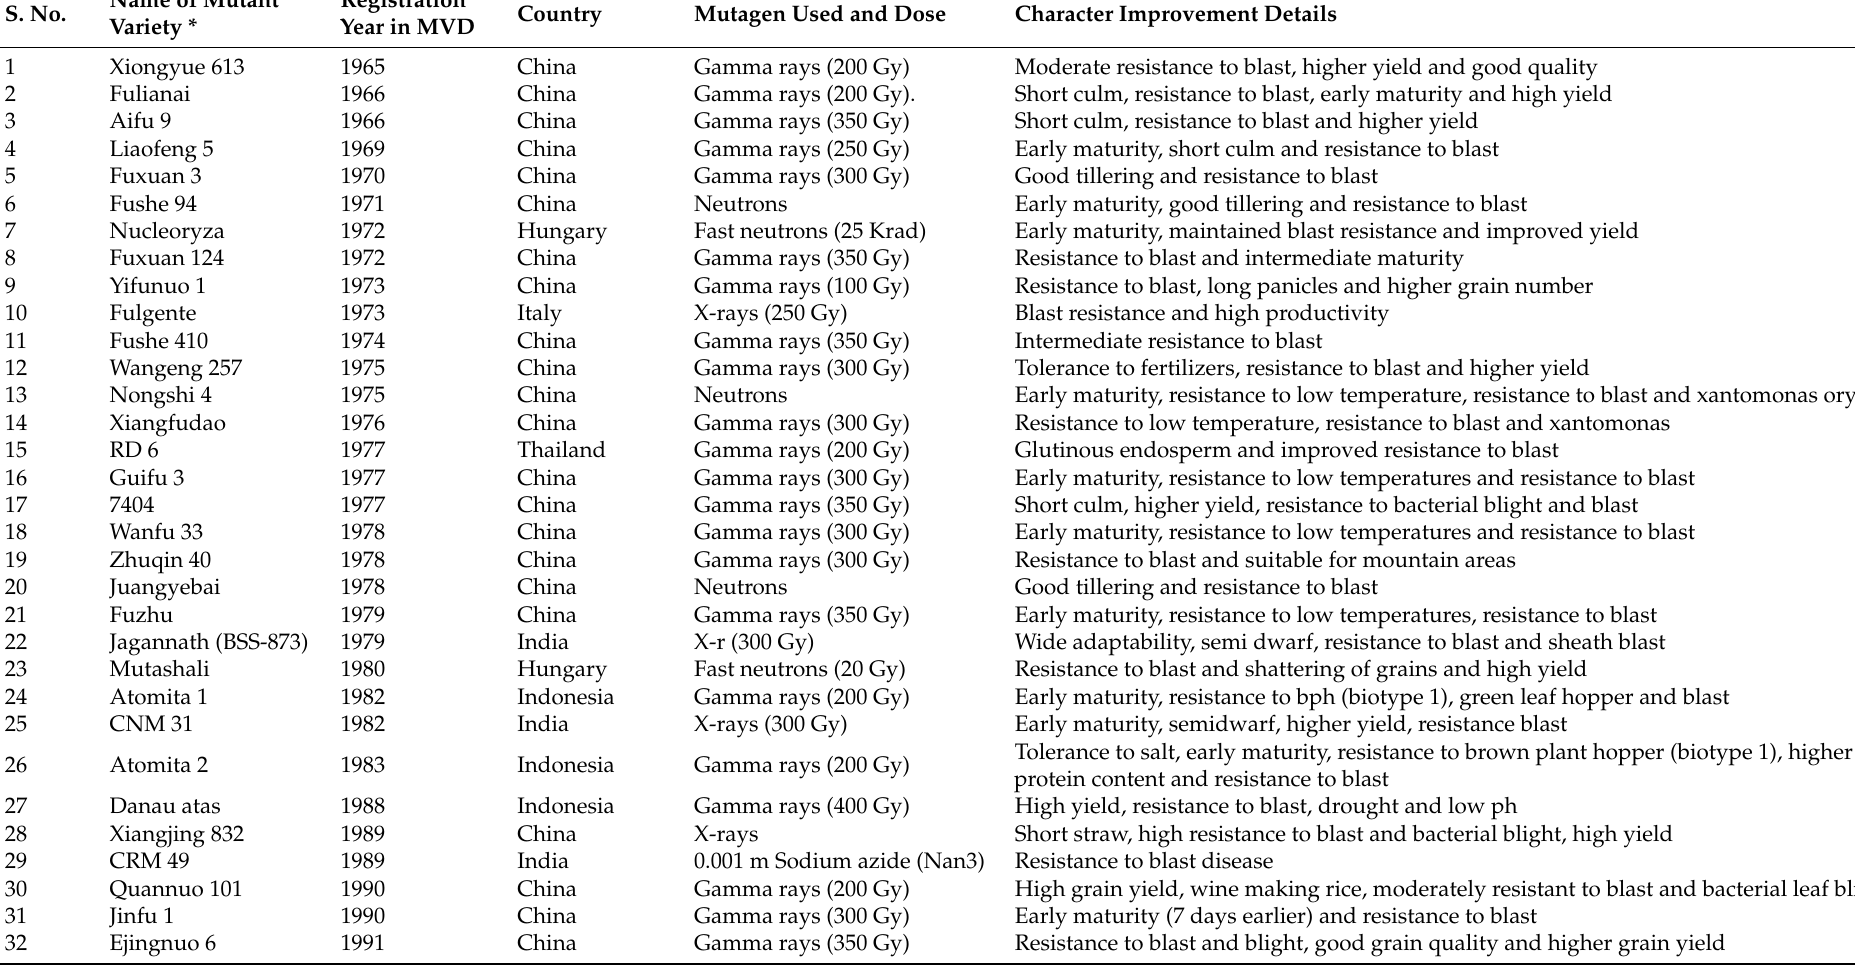
Table 1. List of blast-resistant rice mutant varieties developed across the